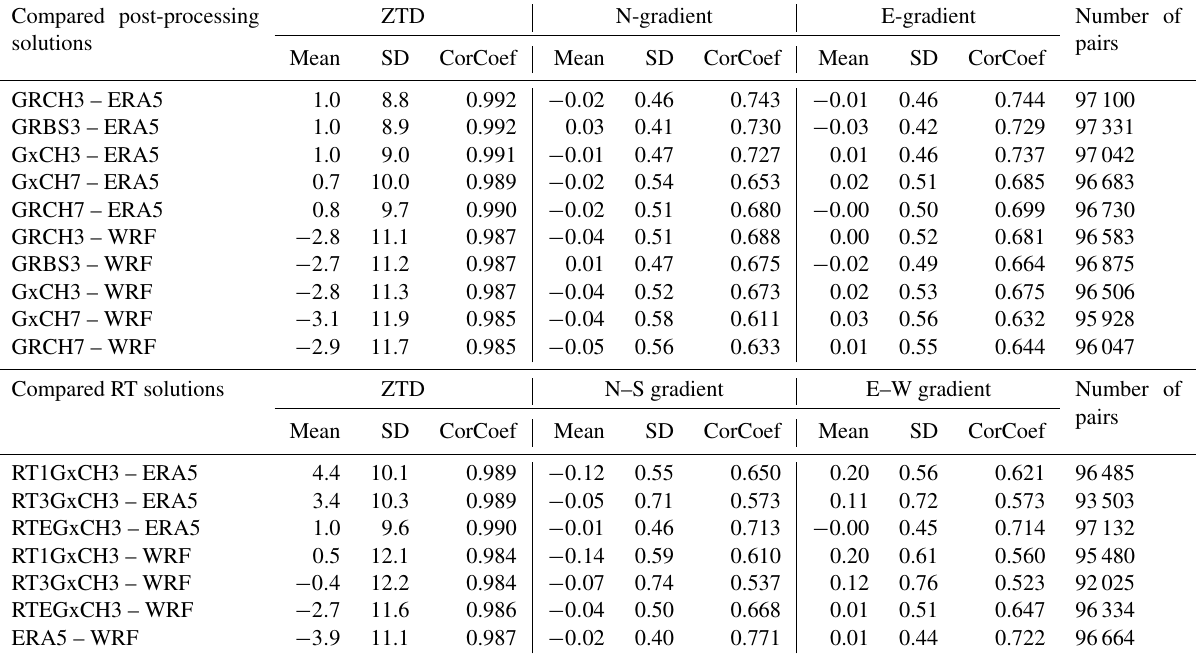
Table 5. Comparison of individual variants of the GNSS data processing run in post-processing mode (top) and in simulated real-time mode (bottom) with NWM solutions. Units: mean and SD in millimetres; CorCoef represents a linear correlation coefficient. Compared